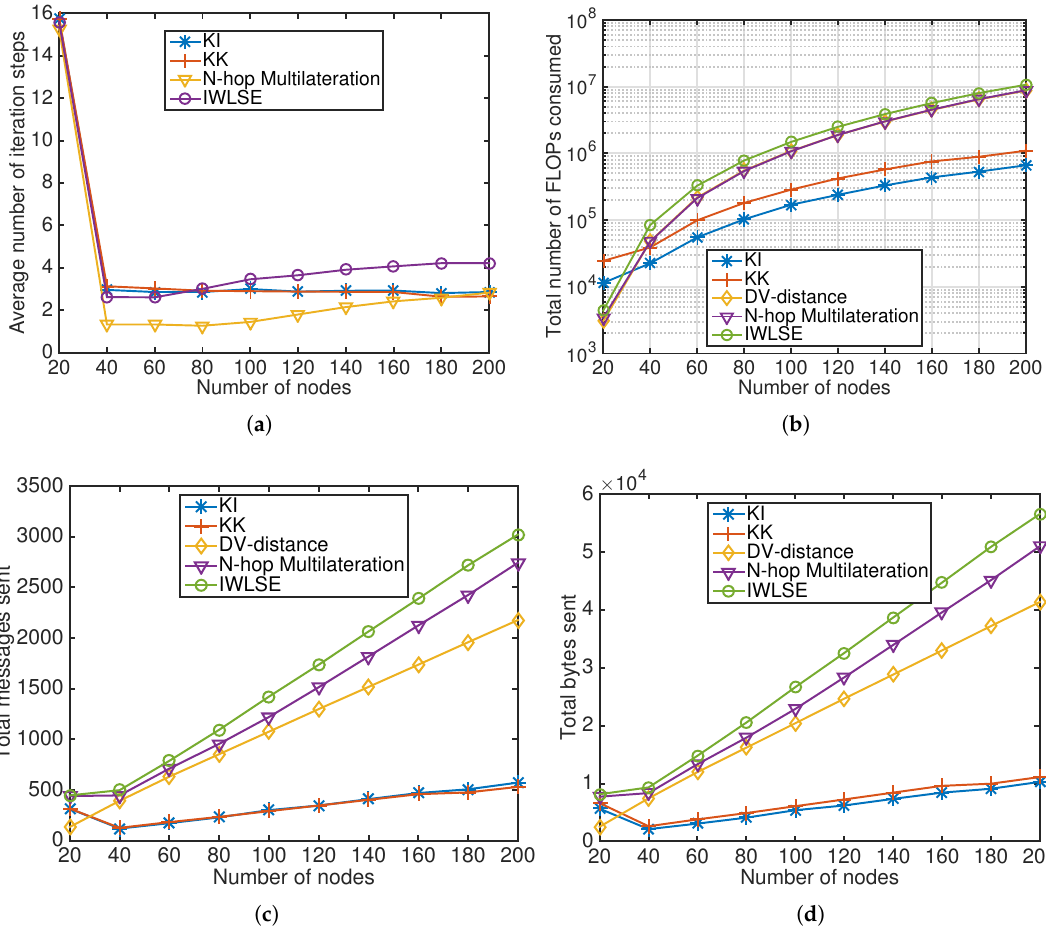
Figure 8. Performance results as a result of changing the number of nodes: ( a ) average number of iterations, ( b ) total number of FLOPs consumed, ( c ) total messages sent, and ( d ) total bytes